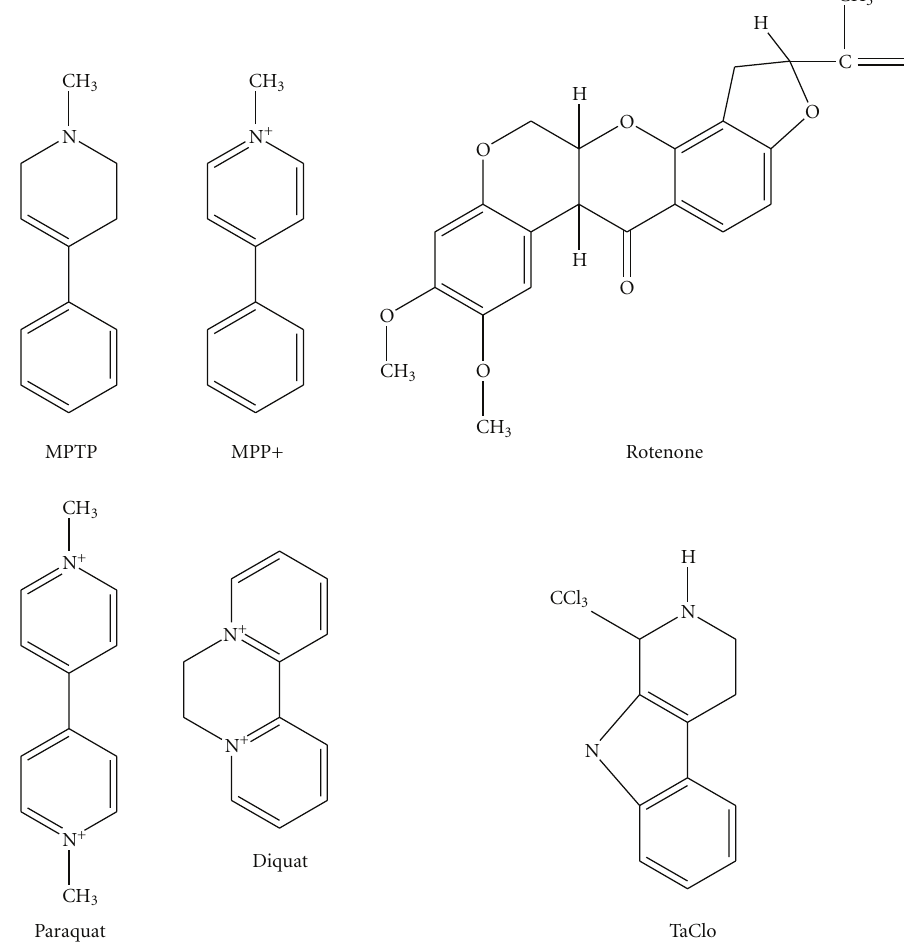
there is also evidence to suggest rotenone causes damage to neurons in the striatum but not SNpc [187], suggesting that it may not be an entirely accurate model of